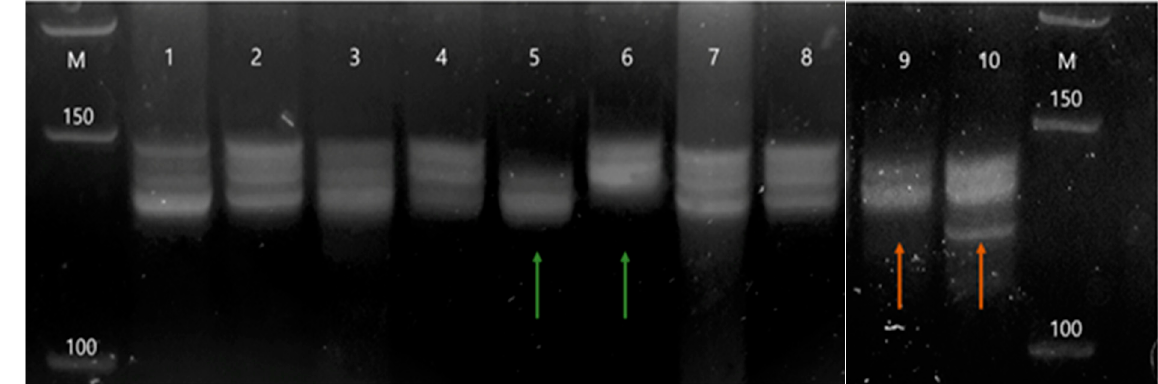
Figure 1. Examples of genetic changes—MSI and LOH, found in intracranial meningioma and detected on Spreadex gels. Legend: M—marker; odd numbers—tumor samples; even numbers—blood samples; green arrows—example of MSI in a tumor sample; red arrows—example of LOH in a tumor sample.